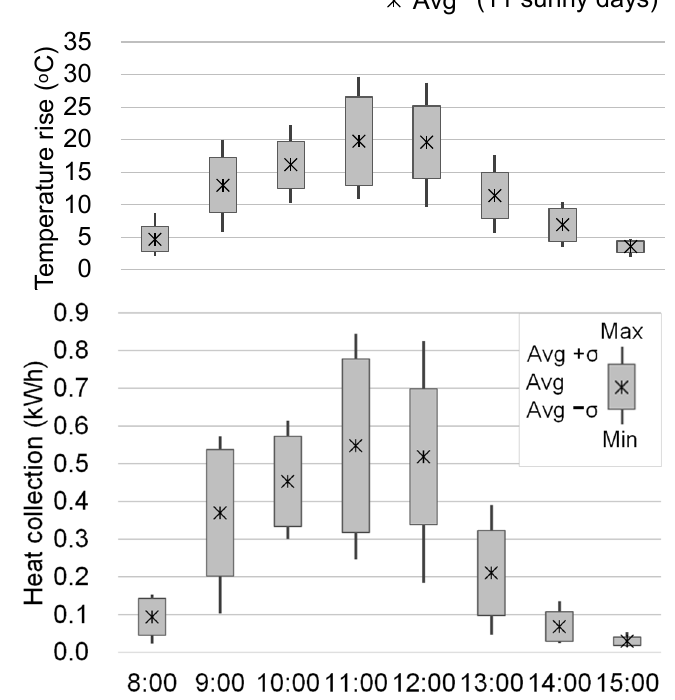
Figure 7. Temperature rise effect and heat collecting effect by time.